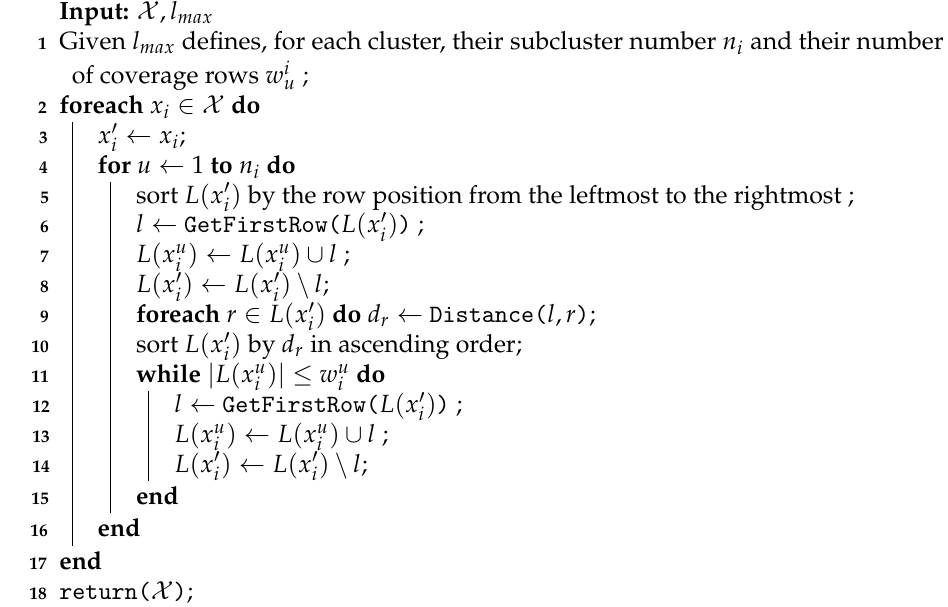
Algorithm 3: Splitting into